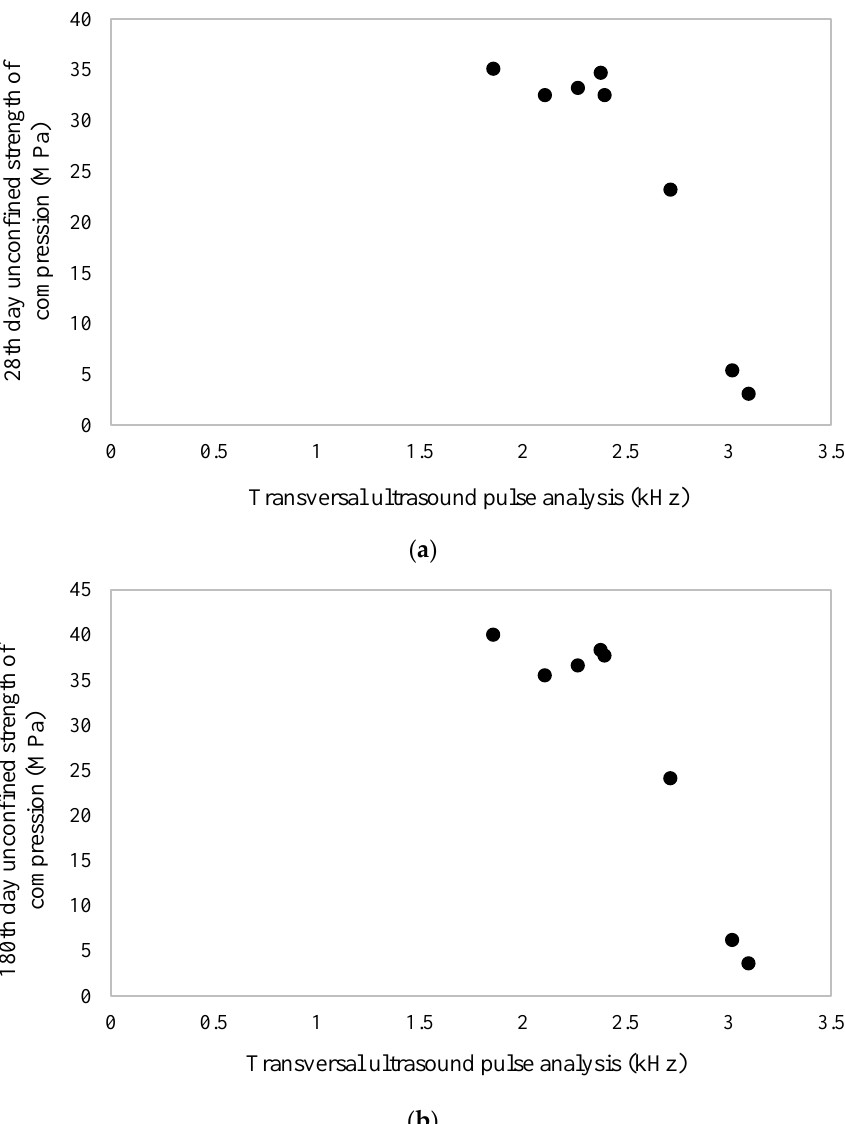
Figure 3. Powerful correlation among the unconfined strength of compression and transversal UPA on the ( a ) 28th day and ( b ) 180th day.